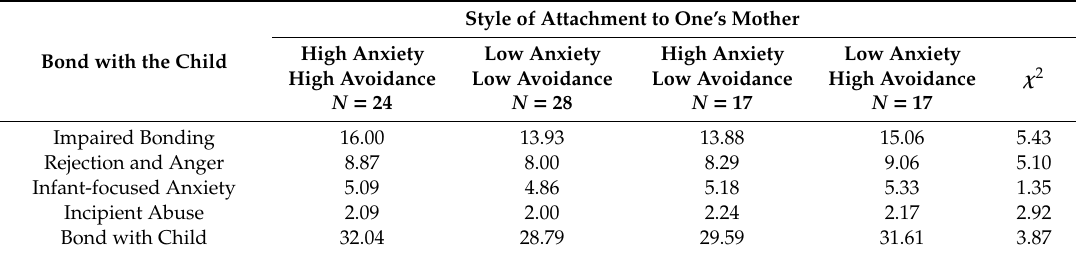
Table 3. Bond with child in mothers with di ff erent styles of attachment to their mothers.